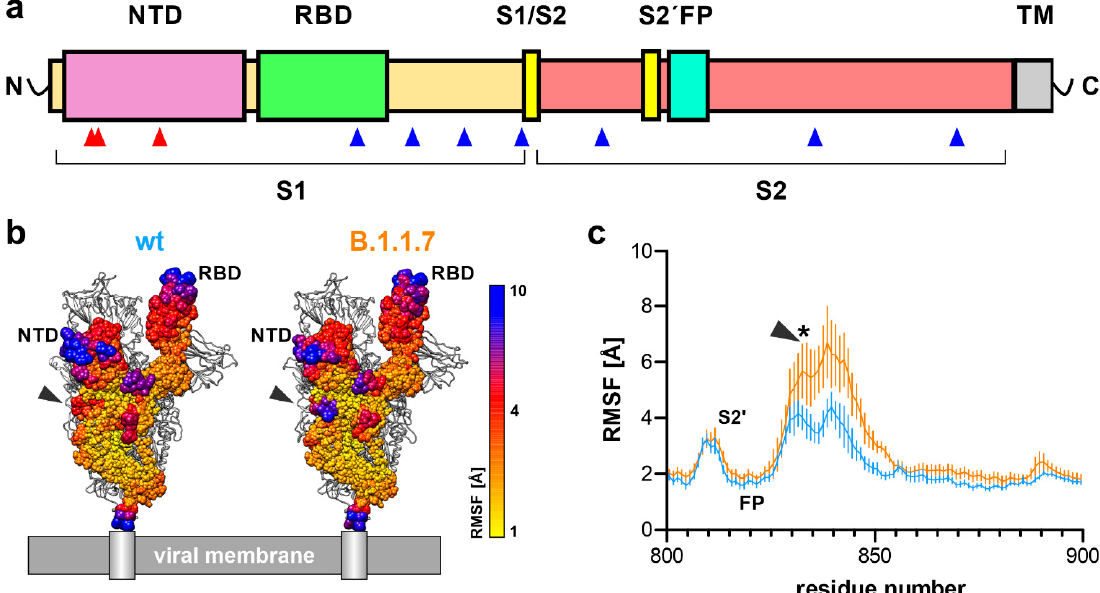
Figure 1. Structural flexibility in the B.1.1.7 SARS-CoV-2 S protein. ( a ) Schematic primary structure of the SARS-CoV-2 S protein indicating the site of amino acid deletions (red arrowheads) or single amino acid exchanges (blue arrowheads; NTD, N-terminal domain; RBD, receptor-binding domain; S1/S2, furin cleavage site at positions 685/686; S2 ′ , furin/TMPRSS2 cleavage site at positions 815/816; FP, fusion peptide; TM, transmembrane domain and C-terminal end). ( b ) S protein trimer as it would reside on the cell surface with one subunit colored for structural flexibility as calculated during simulation (root-mean-square fluctuations (RMSF), n = 6). NTD denotes the N-terminal domain, RBD the receptor-binding domain and the grey arrowhead the loop region between amino acids 835-843. ( c ) Line plot of RMSF values for amino acid residues 800-900 reveals increased flexibility for residues 835 and 843 in B.1.1.7 (orange) when compared to wt (blue). The arrowhead denotes the same region as in ( b ), and the asterisk indicates statistical differences for these amino acids ( n = 6; two-way ANOVA; statistical significance assumed for * p < 0.05; full statistic can be found in Table S2).